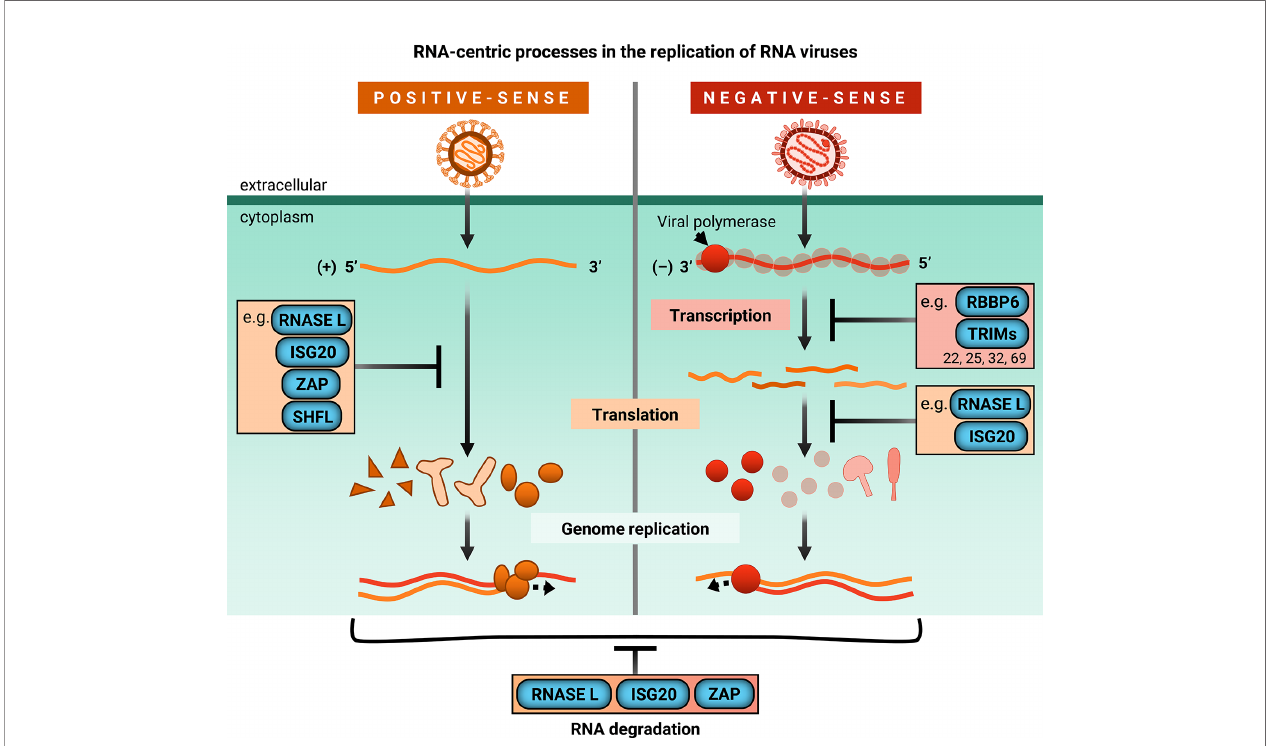
FIGURE 2 | ISGs inhibit RNA-centric processes in replication of RNA viruses. Upon infection, positive-sense single-stranded RNA genomes are directly translated by host machinery. Following expression of viral replicase proteins, genome replication occurs. However, negative-sense single-stranded RNA viruses bring their own RNA-dependent RNA polymerase and viral co-factors to transcribe their genomes before the viral mRNAs can be translated by host machinery for genome replication. ISGs covered in this review are shown to block global or viral translation (RNaseL, ISG20, ZAP, SHFL) and viral transcription (RBBP6, TRIMs). They can also inhibit viral replication by degrading cellular and/or viral RNA (RNase L, ISG20, ZAP). TRIMs that inhibit transcription are limited to those mentioned in this review, speci fi cally TRIM22, TRIM25, TRIM32, and